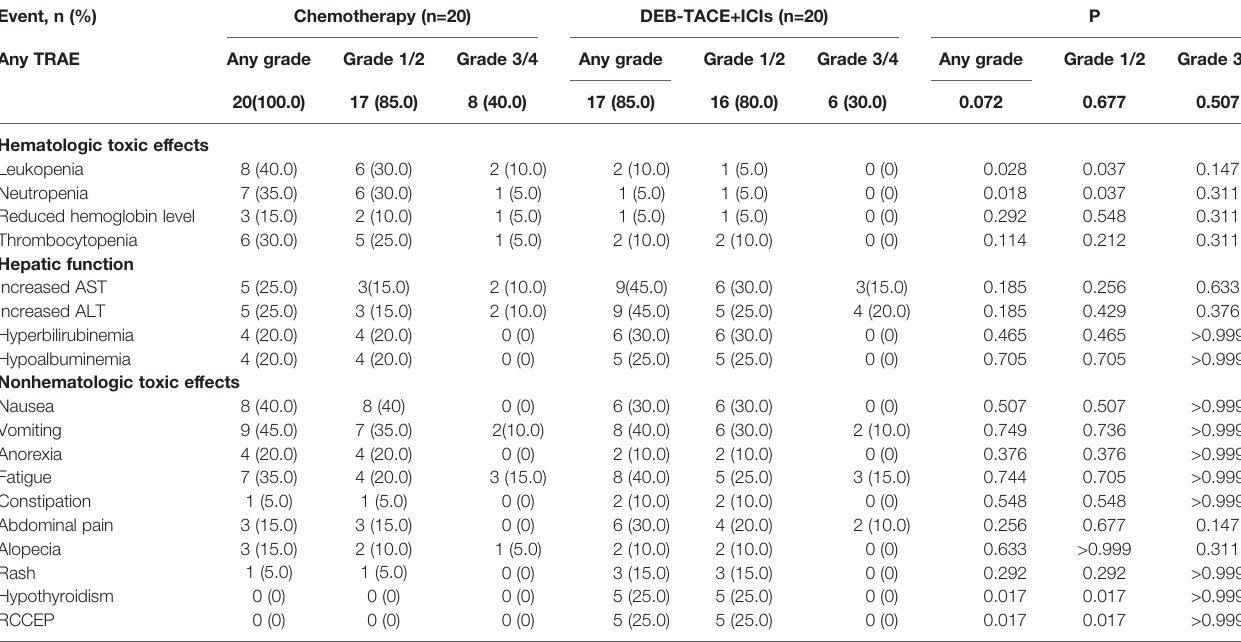
TABLE 4 | Summary of TRAEs after